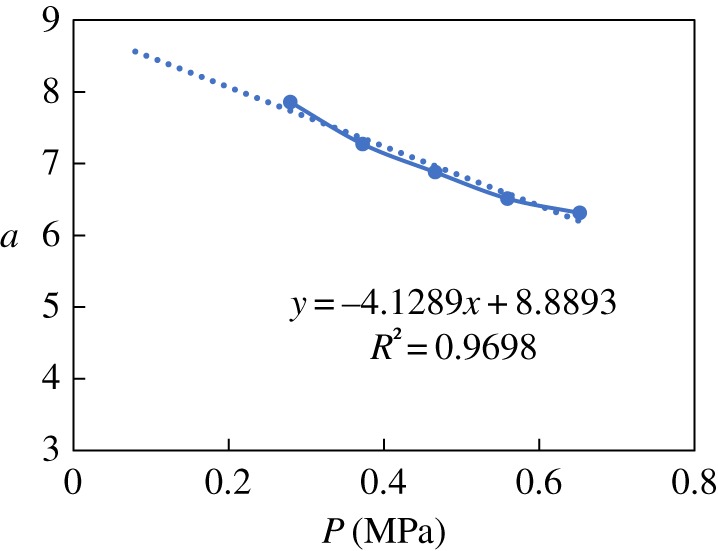
Fitting of constant a2 and pressure.